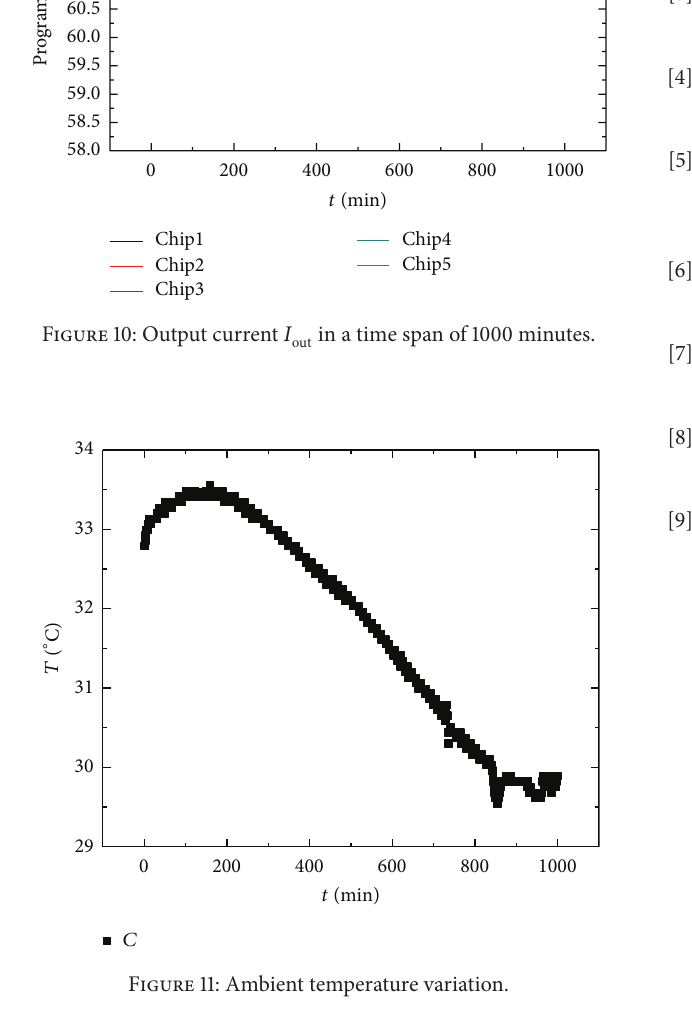
Figure 11: Ambient temperature